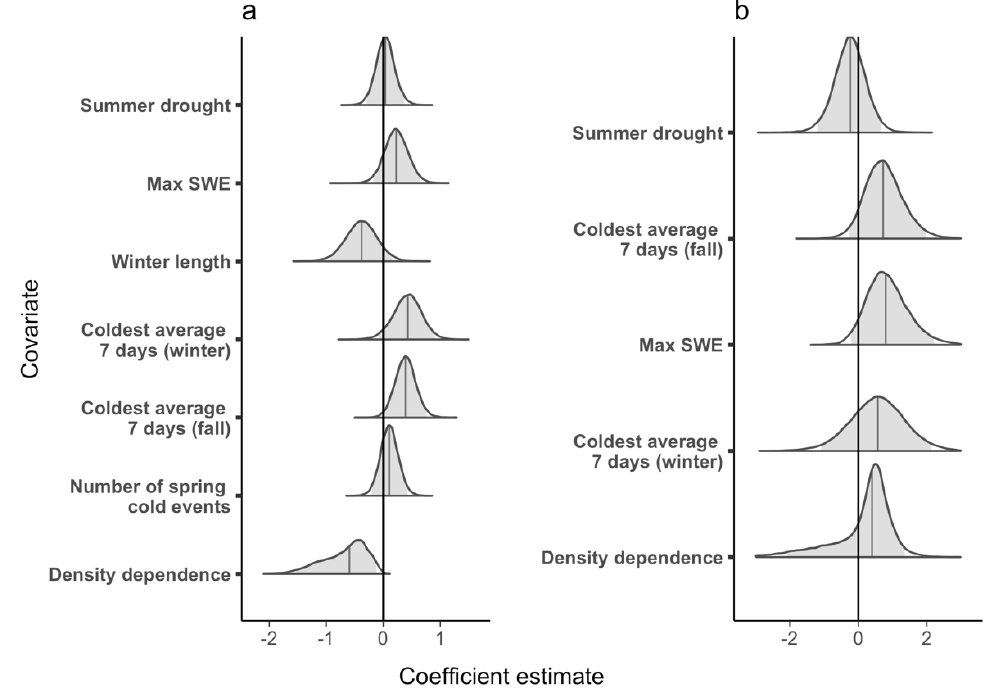
Figure 3. Lily Pond: Posterior parameter distribution for each covariate included in models of ( a ) population growth rate and ( b ) survival. Shaded gray areas indicate the 95% credible intervals and solid lines within the posterior indicate the median value of the coefficient estimates. We considered a covariate to be significant if the 95% credible interval did not overlap zero.